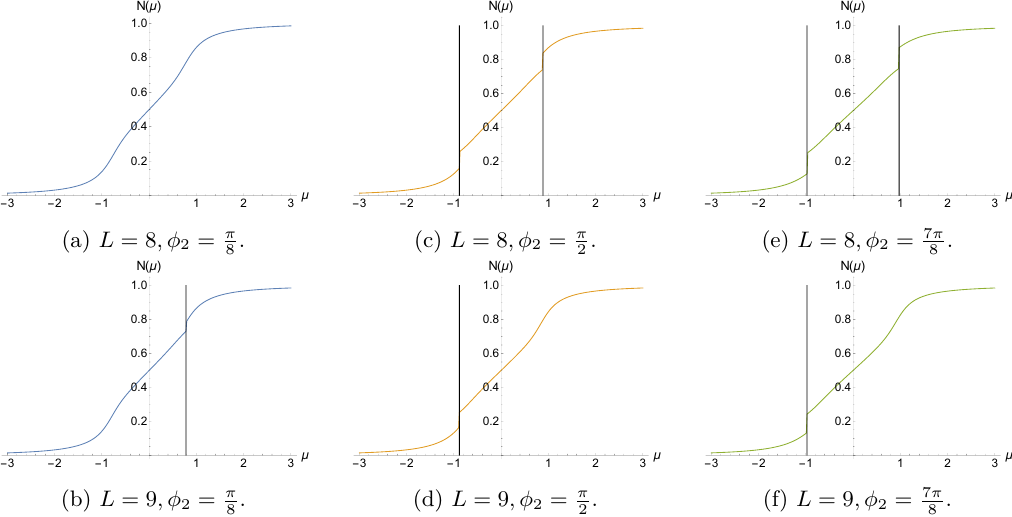
Figure 8 . The expectation value of the number operator as a function of µ with ∆ = J = 1 , . Whenever the energy gap between the first and excited state a = b = 1 . We have fixed φ 1 = − π 4 closes we observe a discontinuity in the expectation value. The values of µ where this happens are pointed out by a vertical black line which lines up exactly with the